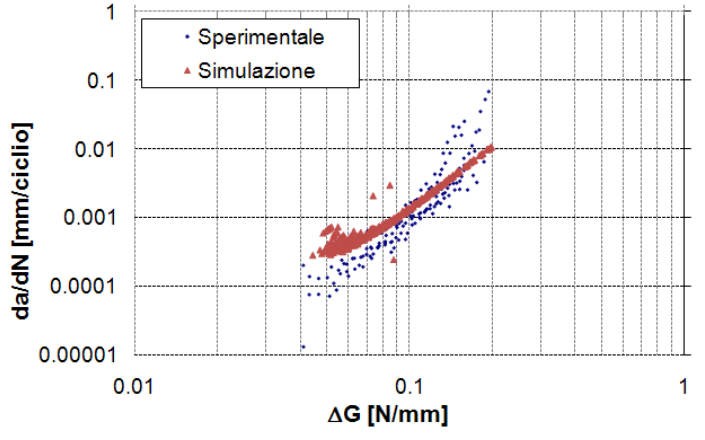
Figura 9: Confronto tra risultati sperimentali e previsione del modello ottenuto con Eq.